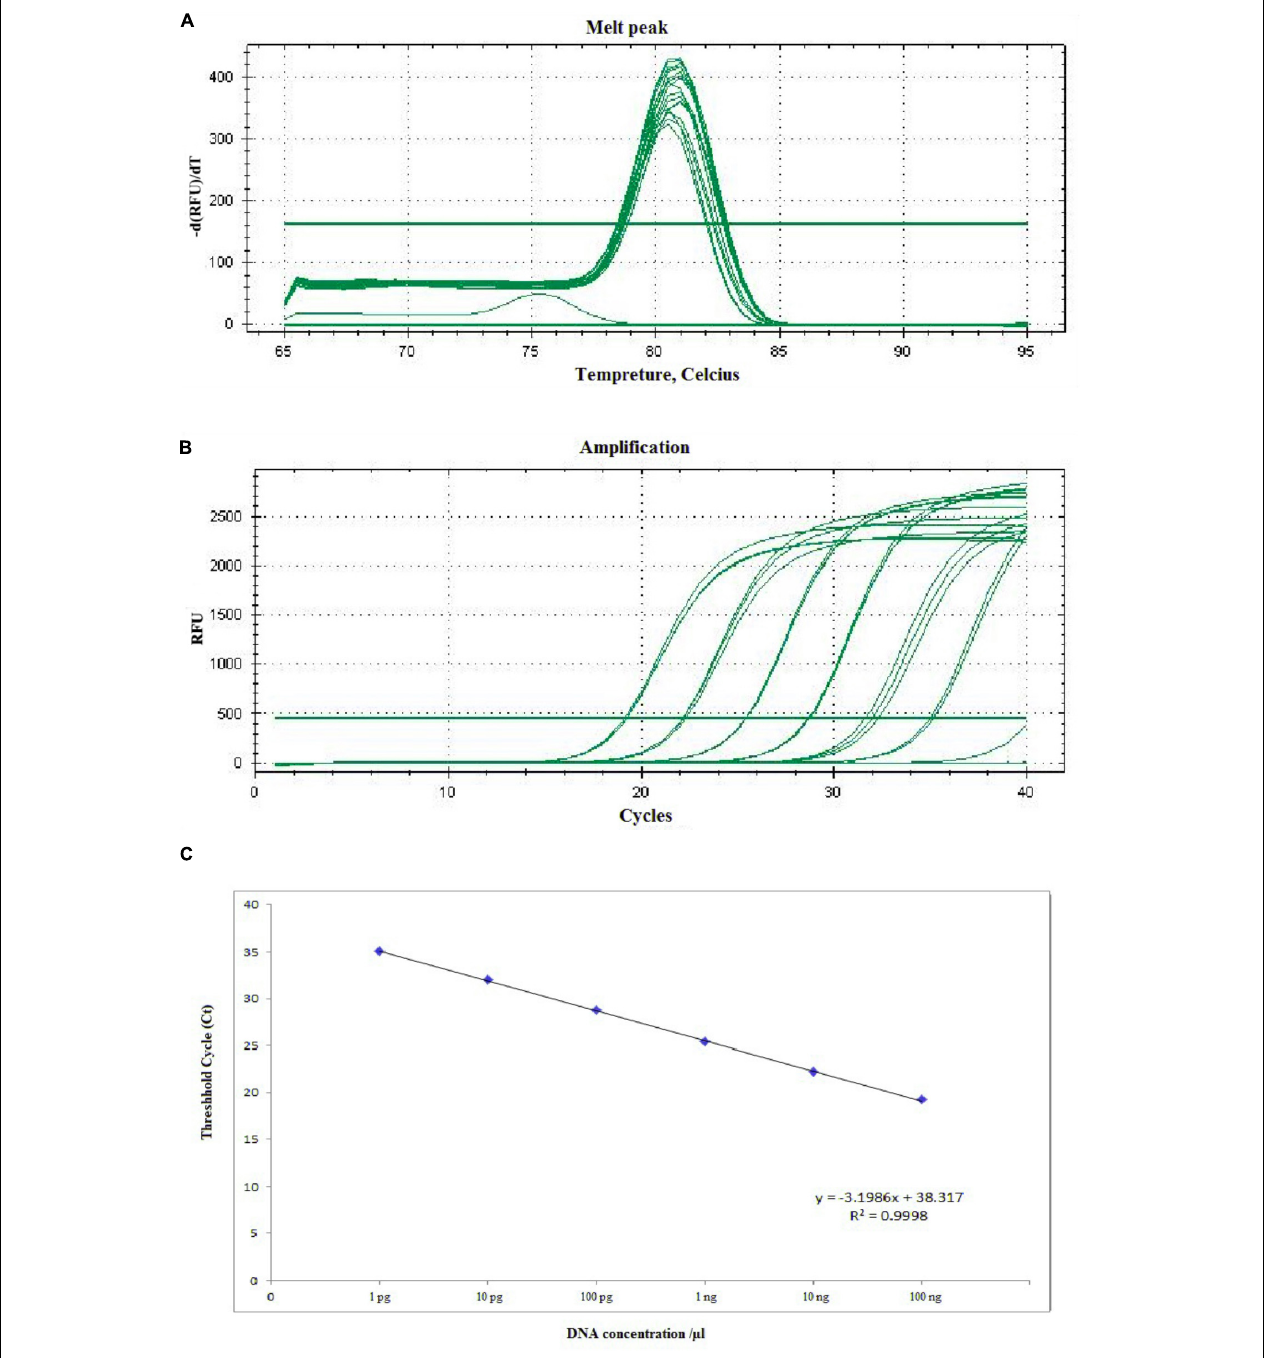
FIGURE 5 | Representative melting curves (A) , amplification plot (B) , and standard curve (C) of real-time PCR for detection of A. solani based on the histidine kinase gene (HK1). (A) Demonstrative melting curves using SYBR Green I for detection of A. solani . (B) A representative amplification plot for 10-fold serial dilution containing 100 ng to 1 pg of genomic DNA. (C) Standard curve derived from absolute quantification of 10-fold serially diluted DNA from a pure culture of A. solani